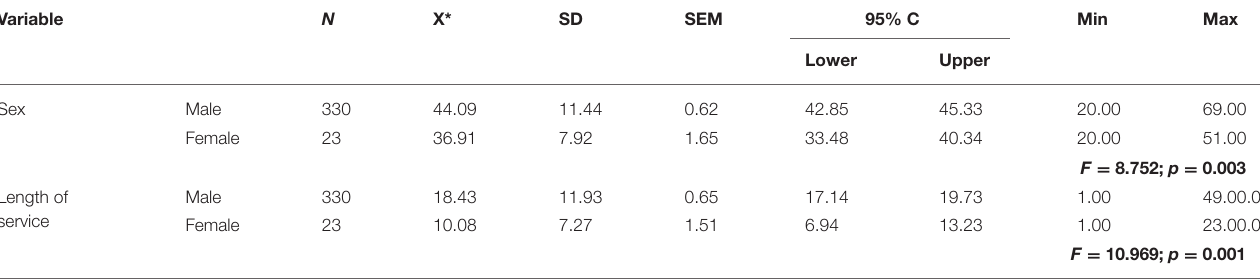
N, Number of responders. X * -average value.